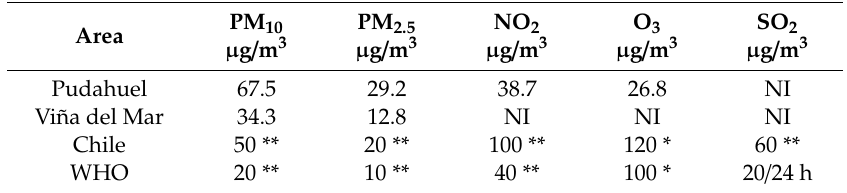
Table 1. Record of the average triannual atmospheric concentrations (2017–2018–2019) and reference limit values of Chile and the